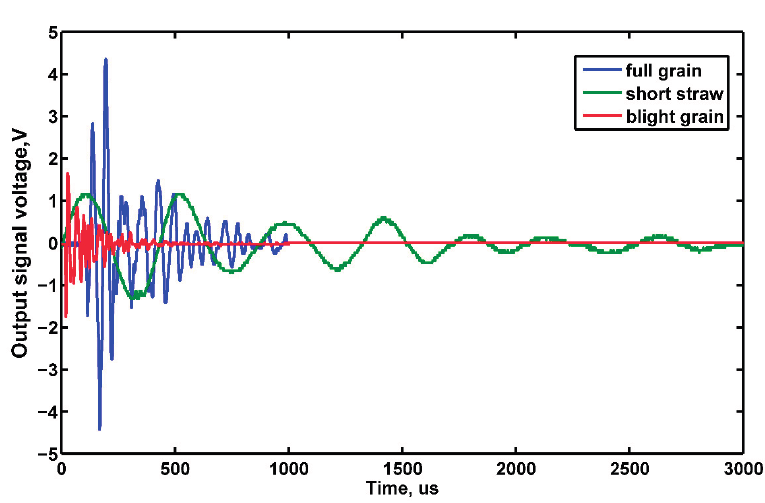
Figure 7. Experimental results of rice grain and MOG impacts with the sensitive plate.